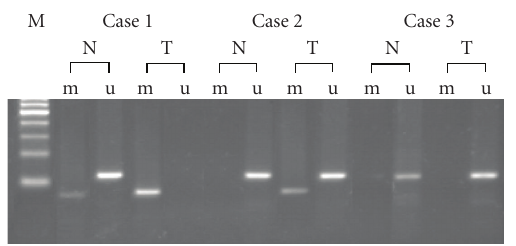
Figure 1: Methylation analysis of TSP1 in tumor tissue (T) and corresponding normal tissue (N). u: indicates the presence of unmethylated genes; m: indicates the presence of methylated genes; M: 100bp DNA marker. Case 1: the tumor is fully methylated, whereas the corresponding normal tissue has a very faint band demonstrating methylation; Case2: tumor-specific methylation;